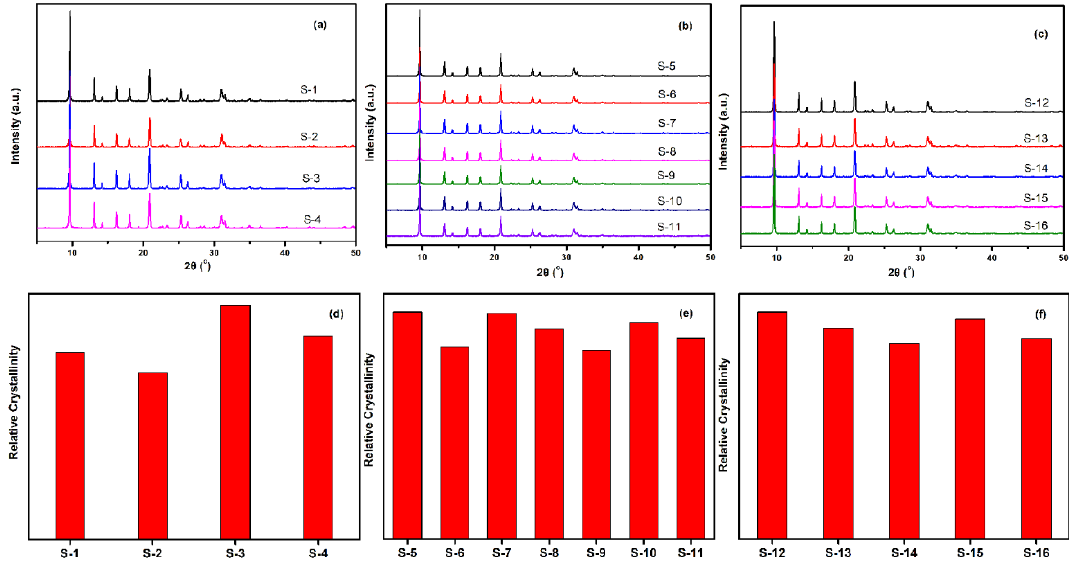
Figure 4. XRD pattern (top) and relative crystallinity (bottom) of SSZ-13 with different Si/Al ratios. ( a ) and ( d ) for Si/Al = 8 SSZ-13 materials; ( b ) and ( e ) for Si/Al = 15 SSZ-13 materials; ( c ) and ( f ) for Si/Al = 25 SSZ-13 materials. S-1, Sample 1.